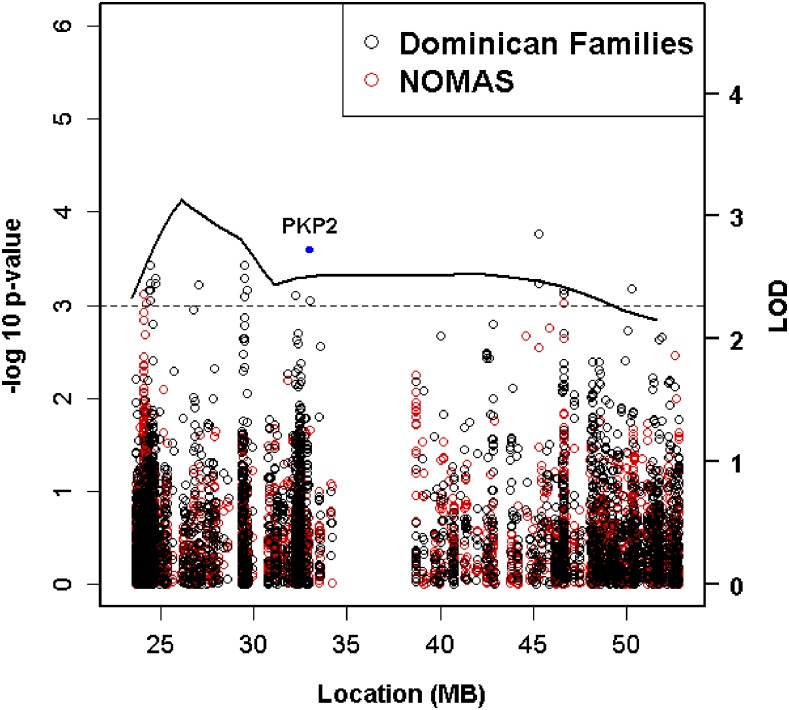
Peak-wide common variant association results for the chr12p11 region. The multipoint LOD score over the region is shown as a solid line. Red circles represent Quantitative Transmission-Disequilibrium P-values in the Dominican families and black circles represent linear regression P-values in NOMAS. The blue dot above the multipoint LOD score line indicates the position of PKP2. The dashed line indicates suggestive association at P < 0.001.